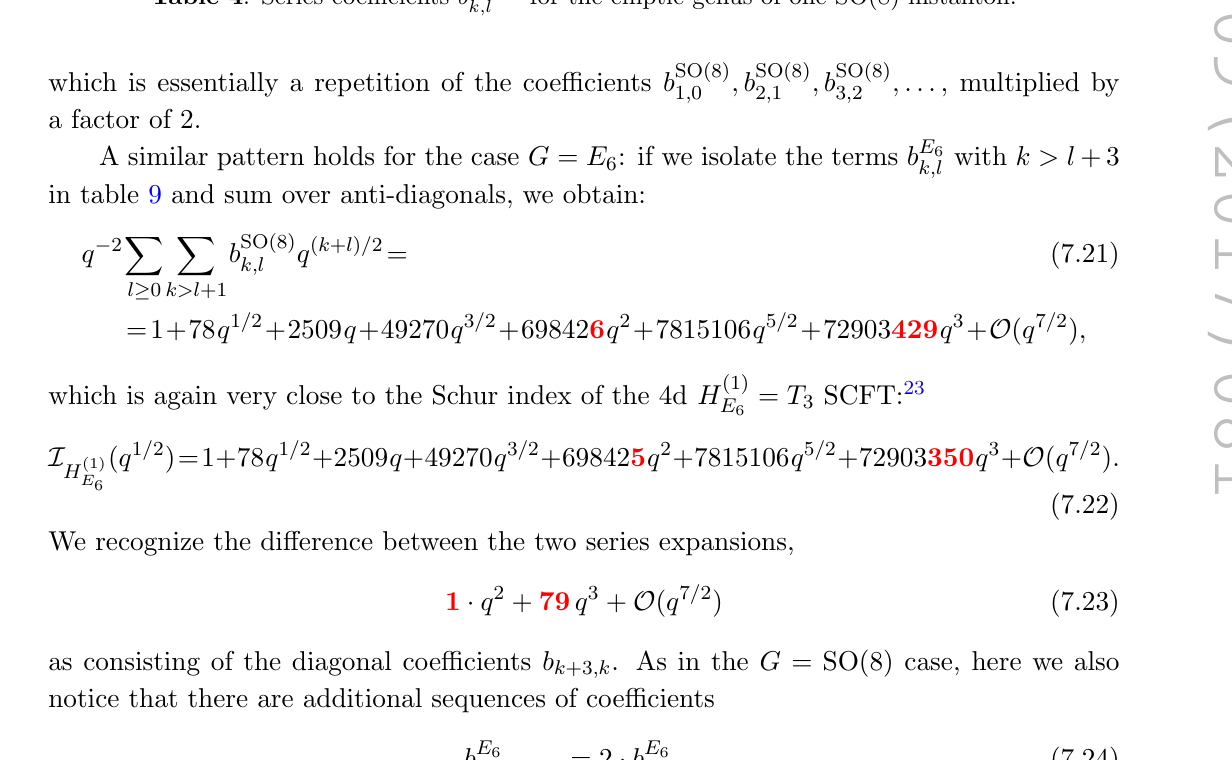
Table 4 . Series coe(cid:14)cients b SO(8)